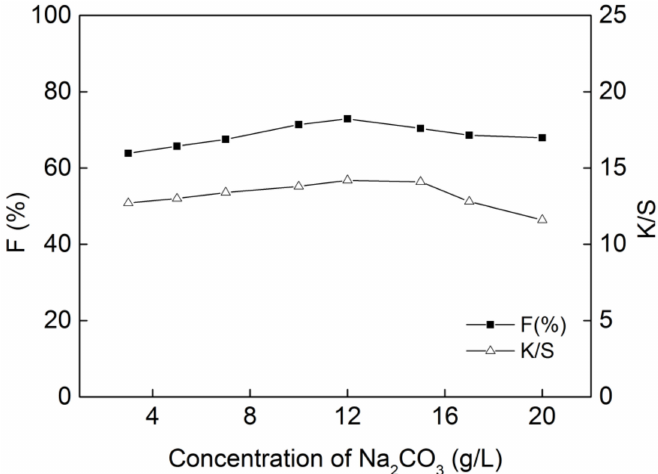
Figure 3. Effect of Na 2 CO 3 concentration on dyeing properties of DB 1 (dye concentration of 40 g/L, dipping time of 3 min and steaming time of 15 min with “one-dip–one-nip” process).